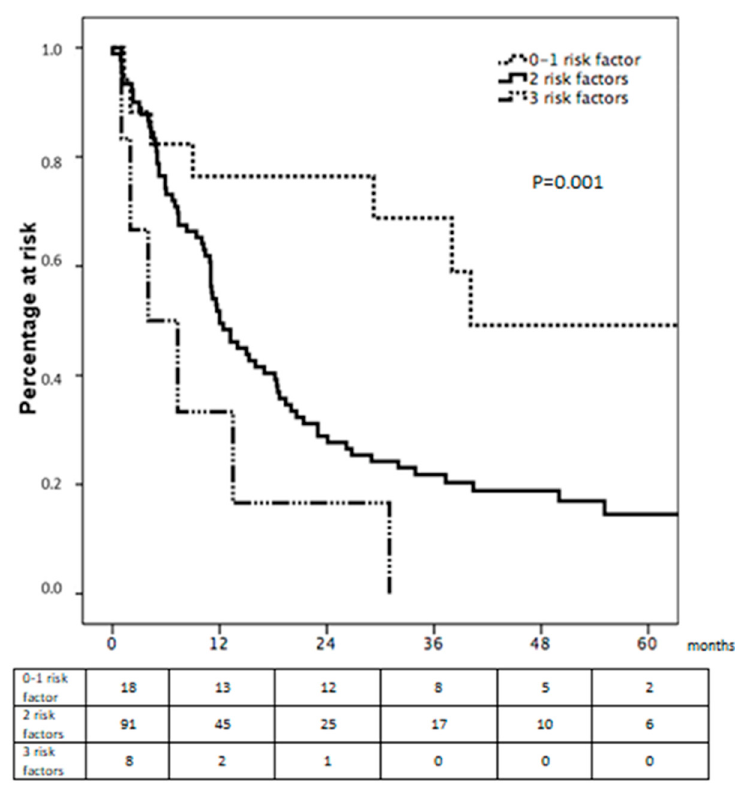
Figure 3. Cumulative effect of negative prognostic factors.